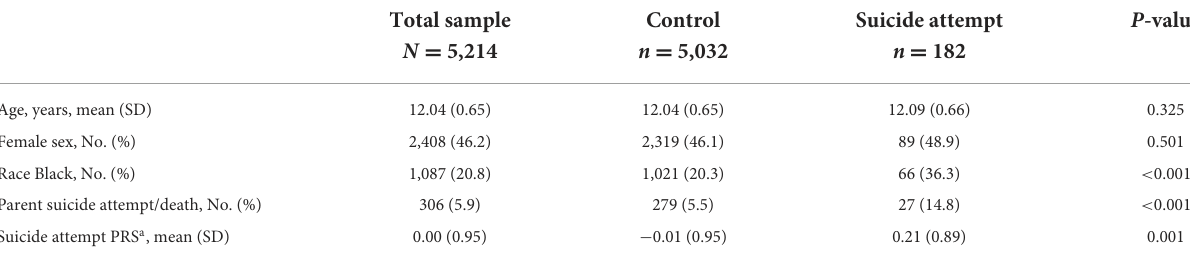
TABLE 1 Sample characteristics and univariate comparison between suicide attempters and controls.